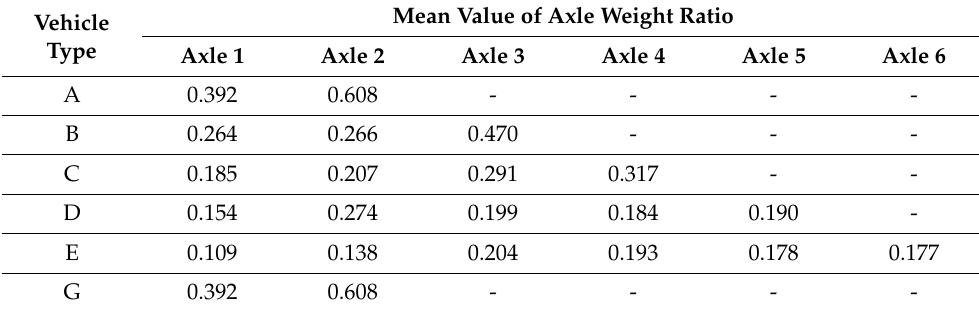
Table 3. Mean values of axle weight ratio for different vehicle types.